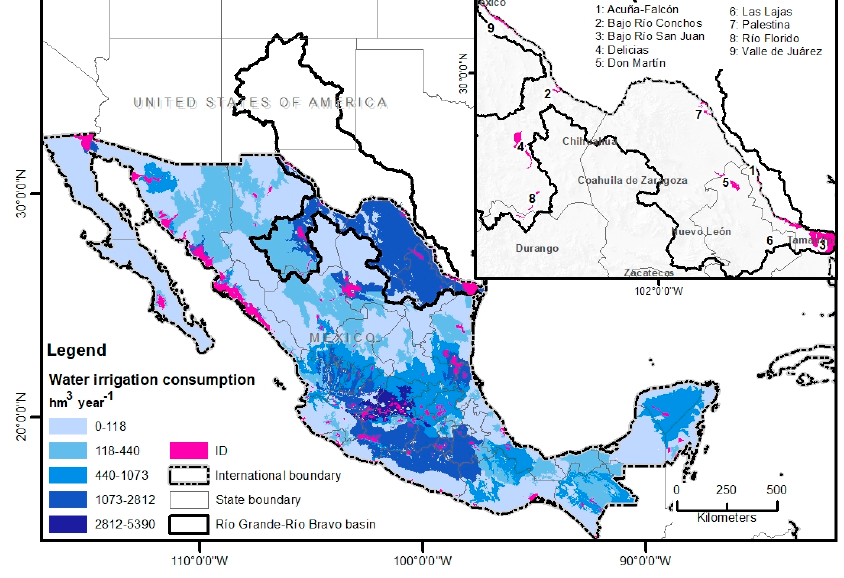
Figure 1. Location of the study area.